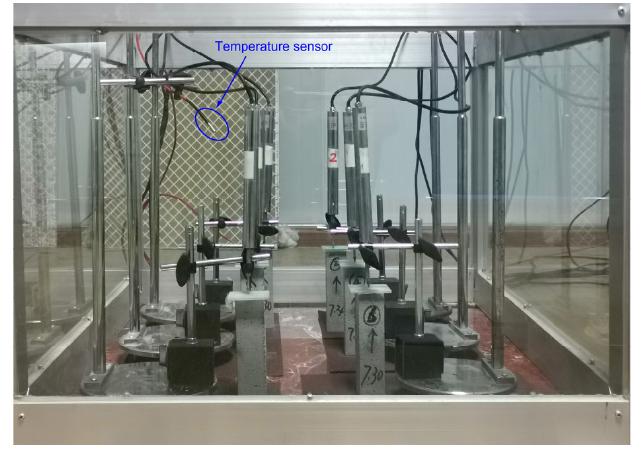
Figure 1. Shrinkage test of the cement mortar specimens.